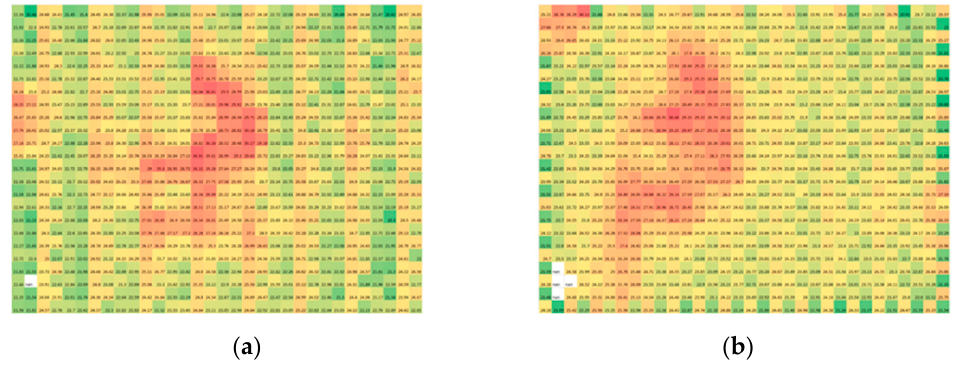
Figure 6. The thermal image ( a ) before and ( b ) after the pre-processing phase, where a non-uniform mean filter is applied, and the NaN values are removed.